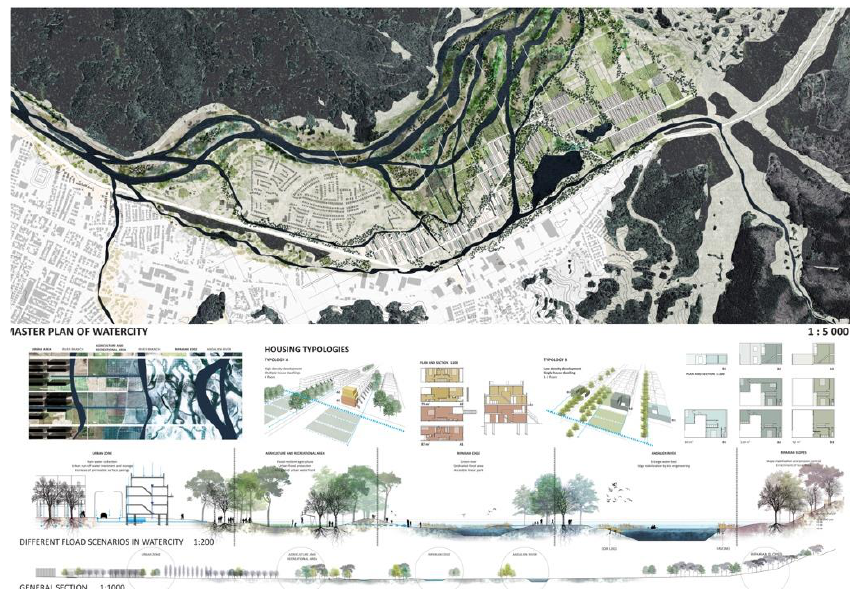
Figure 5. Three river sequence. The design strategy that dialogues with the principles is the definition of urban-river tissue where the river can move and reconnect the watercourses with existing wetlands. A section is designed as a dialogue between housing which considers permeable spaces between buildings to allocate water flows. Source: By the authors: Cummings, Malcolm, Pirks, Priore and Urgelles Calvet in [52].